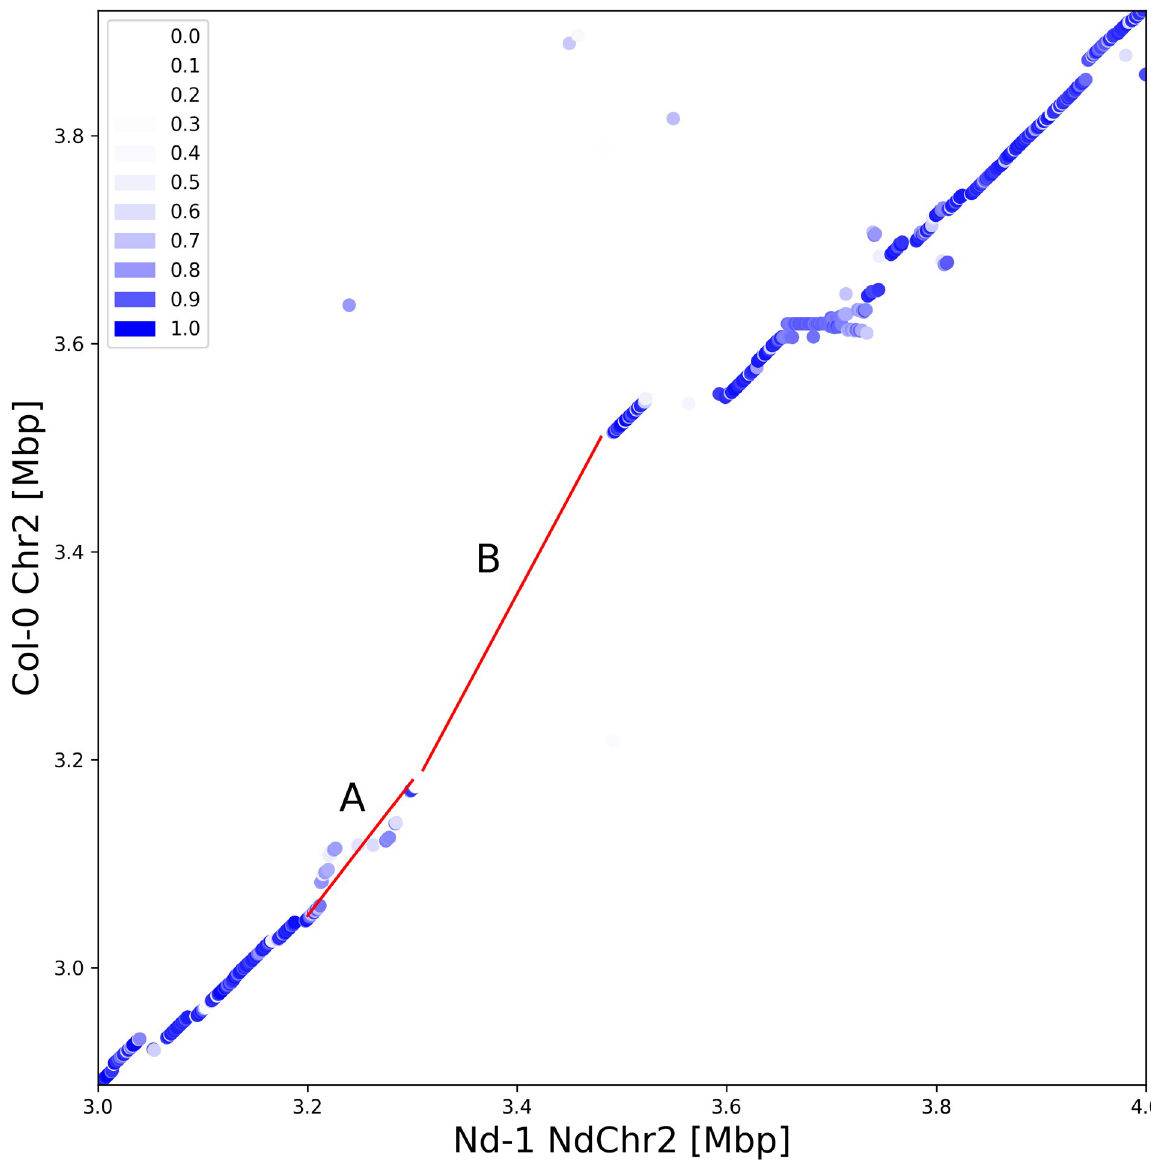
Fig 3. Highly divergent region on chromosome 2. There is a very low similarity region (light blue) between the sequences in region A and almost no similarity between the sequences in region B (white). The complete region between 3.29 Mbp and 3.48 Mbp on NdChr2 is missing in the L er